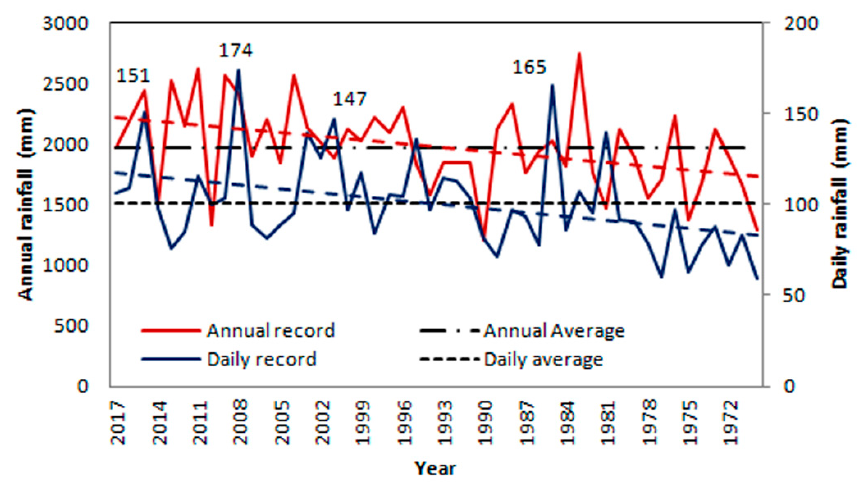
Figure 2. Precipitation records of Batatais State Forest Station relative to period 1970–2017 (red and blue lines), and associated increase trends (dashed black lines). The labels close to blue line peaks refer to precipitations at reported major flood events. The daily precipitation of 174 mm occurred in 29 January 2008 and provoked a severe flood in Batatais.